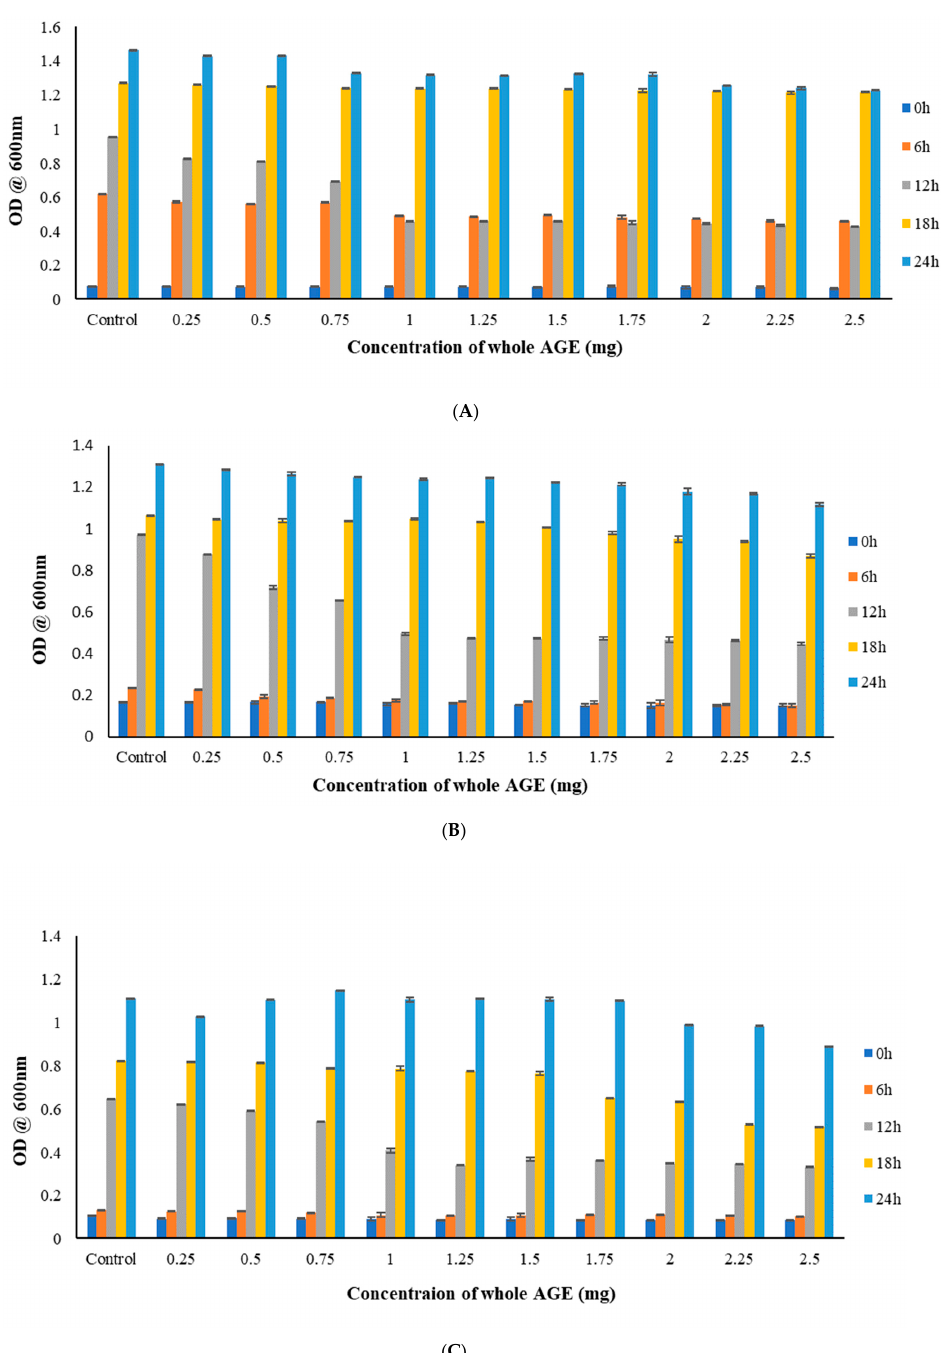
Figure 2. ( A ) Growth OD measurement to assess the antimicrobial activity of whole AGE against C. albicans M207 at different time intervals. MIC 50 was observed at 1 mg at 12 h with a mean value and s.d. of (0.459 ± 0002) and n = 3. ( B ) Growth OD measurement to assess the antimicrobial activity of whole AGE against E. coli ATCC 39936 at different time intervals. MIC 50 was observed at 1.25 mg at 12 h with a mean value and s.d. of (0.475 ± 004) and n = 3. ( C ) Growth OD measurement to assess the antimicrobial activity of whole AGE against C. albicans M207+ E. coli ATCC 39936 at different time intervals. MIC 50 was observed at 1.25 mg at 12 h with a mean value and s.d. of (0.341 ± 008) and n = 3. All values are expressed as mean and standard deviation. Microbial biofilms are highly heterogenous in their composition, usually consisting of both bacteria and fungi, and are encased within a polysaccharide matrix. The cells within the matrix exhibit different behavioural patterns, as compared to the free ‐ living